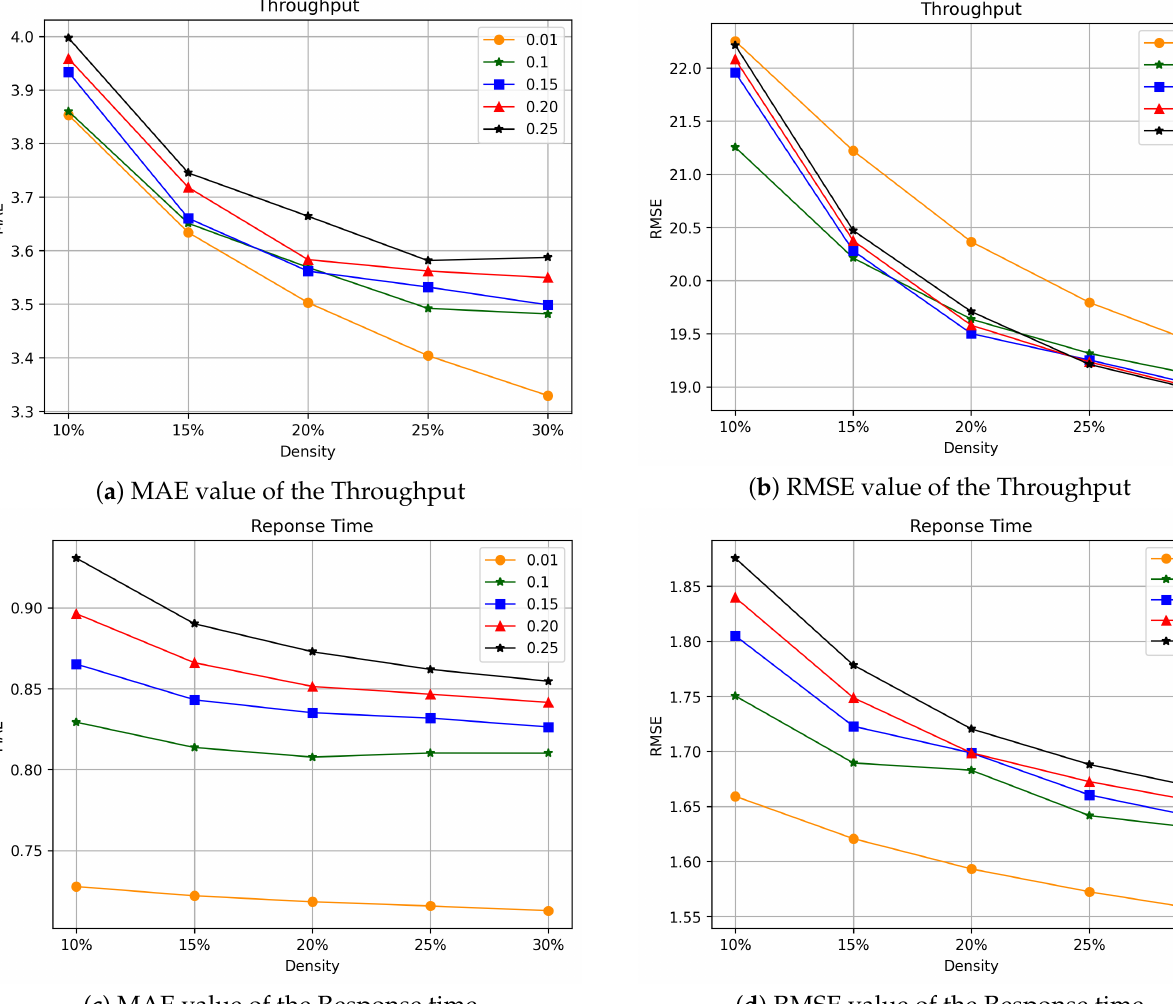
Figure 5. The effect of the truncation rate